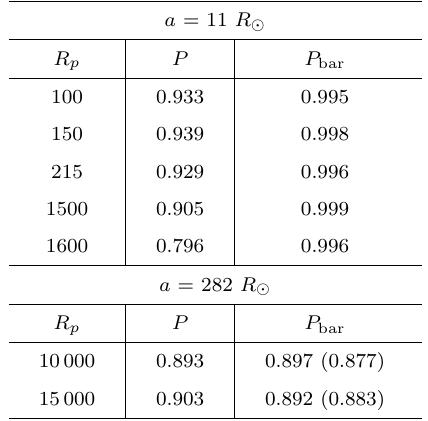
Table 1. Probabilities of hypervelocity star formation: R p is the semimajor axis of the binary and P is the probability estimated in terms of the Fellhauer et al. (2006) model. Here P bar is the probability estimated in terms of the model with a bar with a cosine distribution of angles between the initial velocity vector and the semimajor axis of the bar (the number in brackets is the probability estimated in the case of the uniform distribution of these angles). a = 11 R ⊙ R p P P